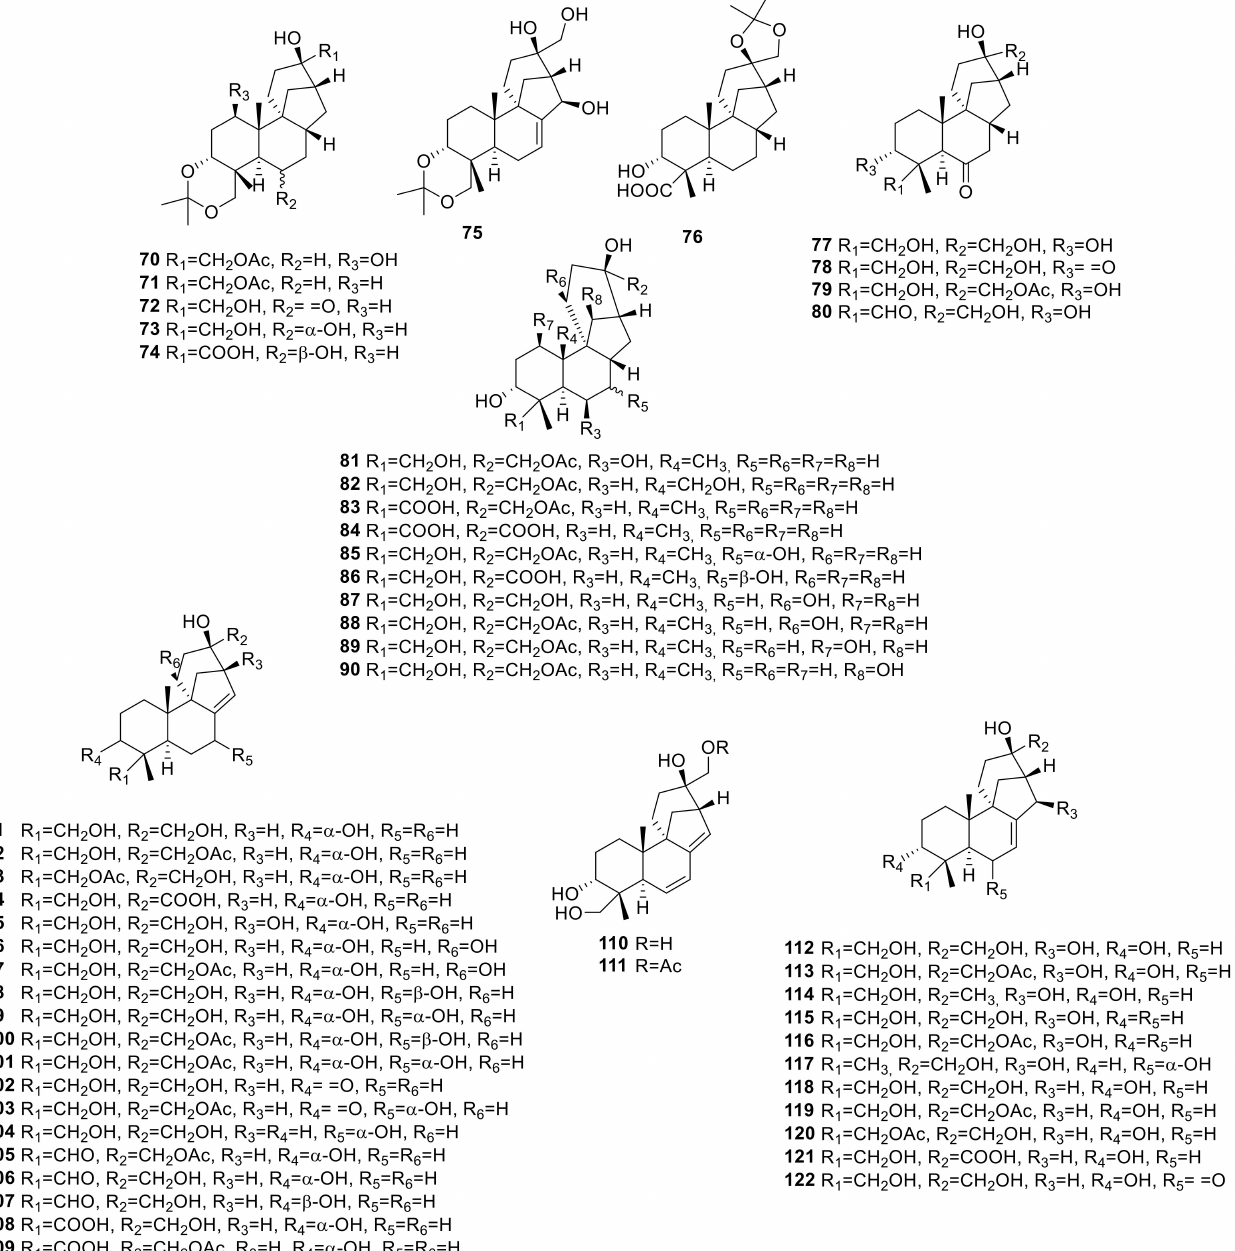
Figure 19. Structures of aphidicolin derivatives 70 - 122